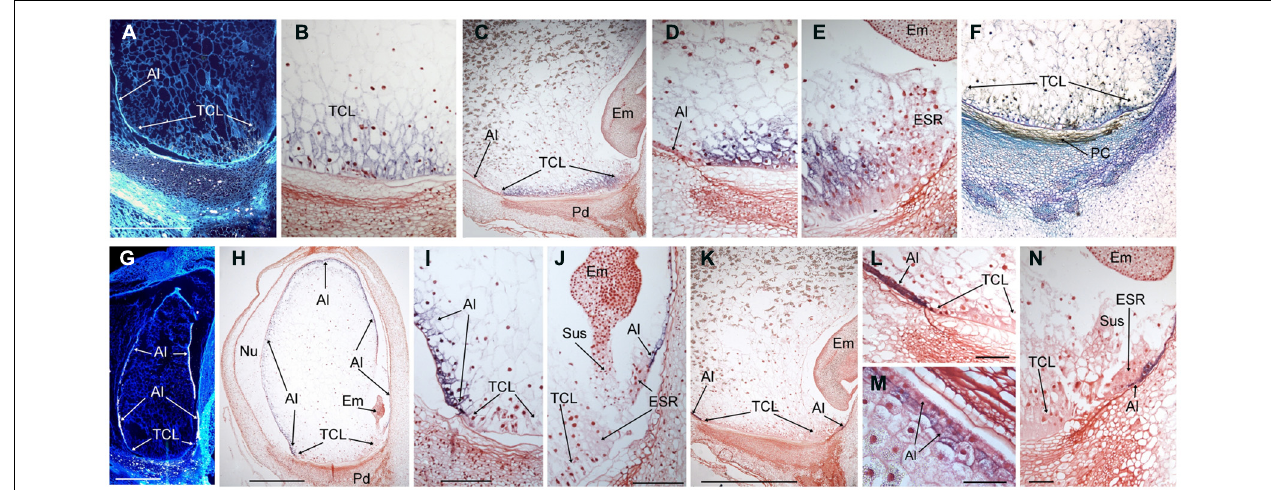
FIGURE 3 | Expression analyses of the BETL9 and BETL9like genes in developing maize kernels. The expression of BETL9 was analyzed by in situ hybridization with antisense RNA probes (A–E) or Immunolocalization (F) with a specific antisera.The expression of BETL9like was analyzed with an antisense RNA probe (G to N). RNA labeling was done with S 35 -dUTP (A,G) or DIG-dUTP (B–E,H–N) . Sections correspond to 5 DAP (A,G) , 10 DAP (B,F,H–J) , and 16 DAP (C–E,K–N) . S 35 hybridization signal appears as light